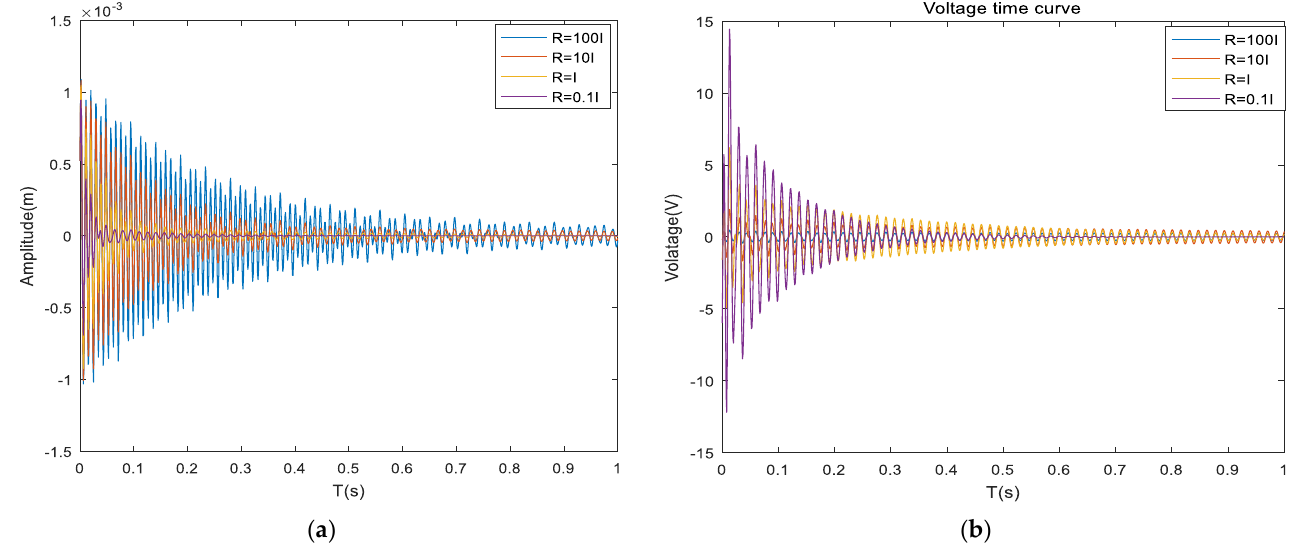
Figure 10. Comparison of system characteristics with different R matrix coefficients. ( a ) Composite sandwich plates displacement time response; ( b ) Composite sandwich panel voltage-time curve.